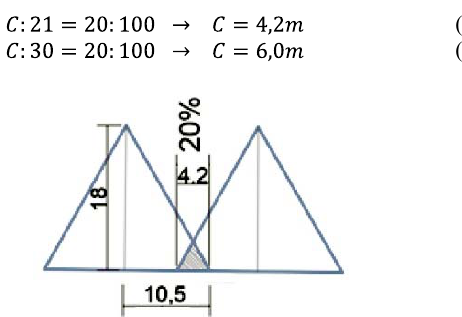
Figure 10. Visualization of the scheme used to identify the Closeness parameter of the scan points – graphic elaboration by